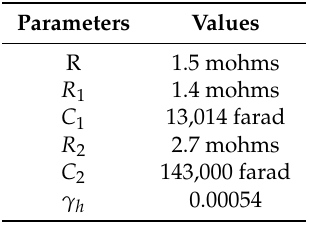
Table 1. Battery Equivalent Circuit Parameters and its